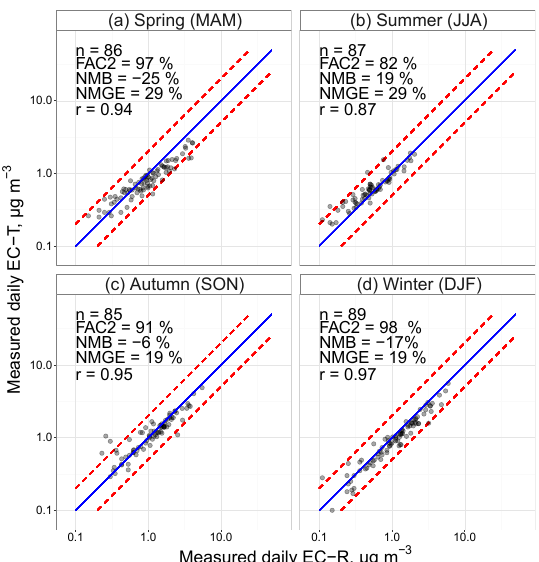
Figure A3. Scatter plot of measured daily average EC split from TC using reflectance (EC-R) against EC split from TC using transmittance (EC-T) at the North Kensington site split by seasons, year 2012.